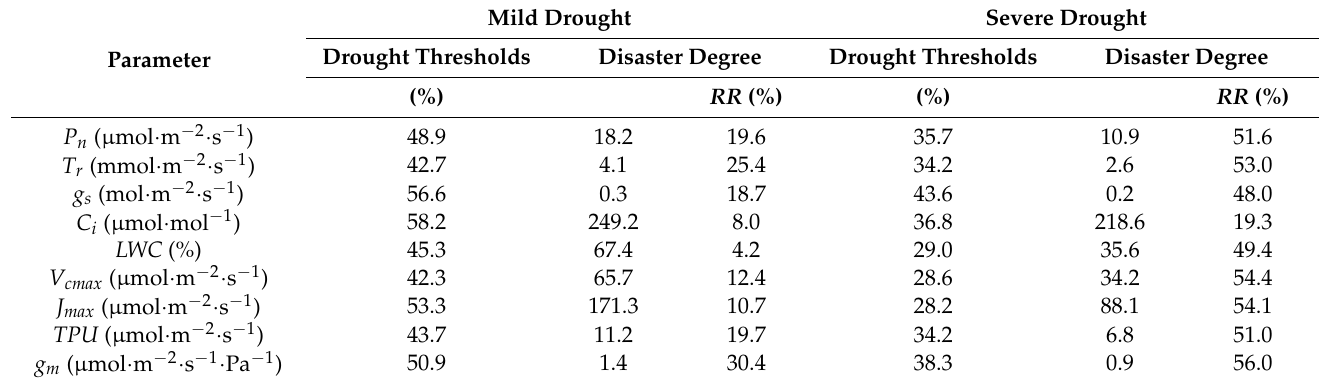
Table 7. Drought thresholds of spring wheat under rapid-drought